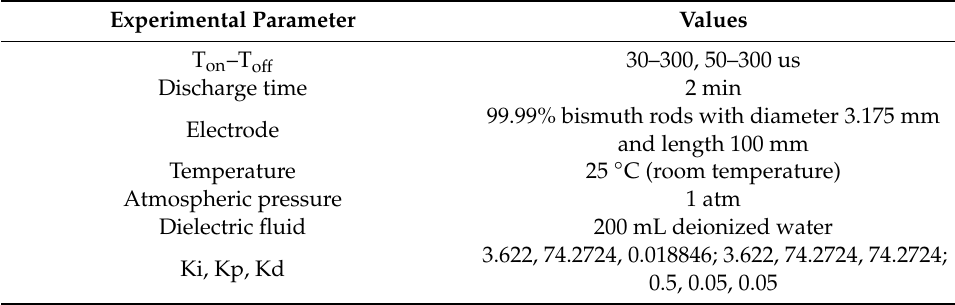
Table 1. Preparation parameters.